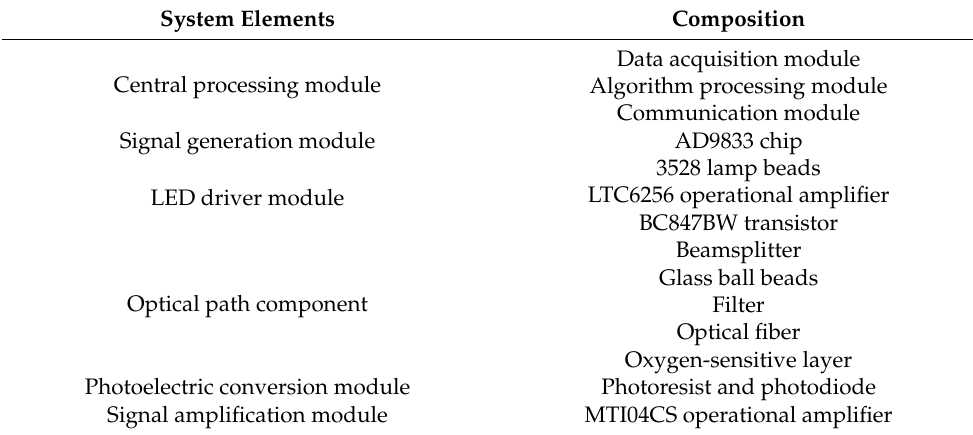
Table 1. The main system modules involved in the sensor.